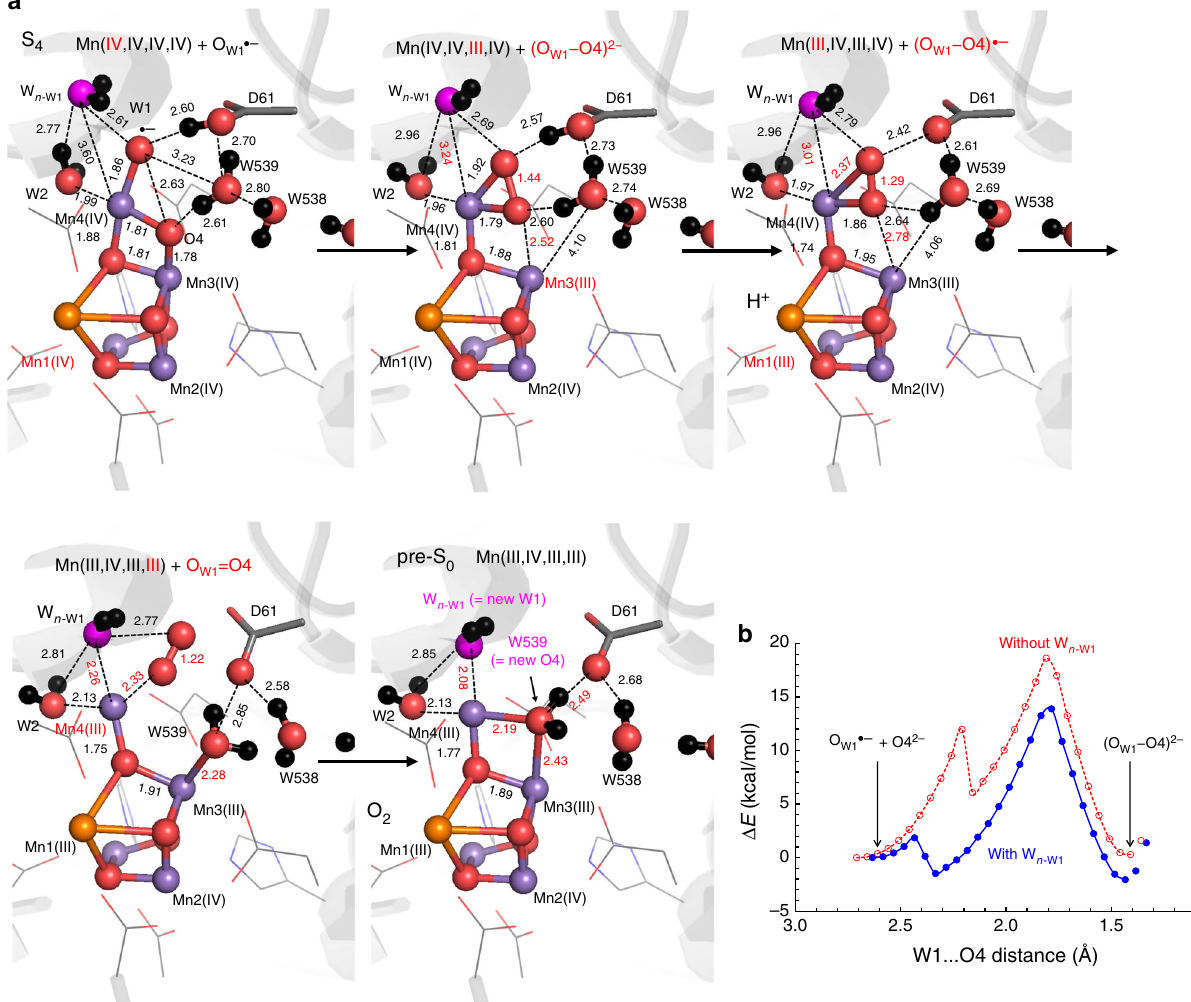
Fig. 4 The S 4 and pre-S 0 states. a QM/MM geometries. Mn, Ca, O, and H atoms are represented by purple, orange, red, and black balls, respectively. Dotted lines indicate distances (excluding H atoms). Release of (O W1 – O4) (cid:129)– from the Mn3/Mn4 moiety (i.e., the Mn3 … O4 distance was increased) resulted in formation of O W1 = O4. See supplementary Figure 4 for the energy pro fi le. b The energy pro fi les of the (O W1 – O4) 2 − formation (the fi rst and second panels in a ) in the presence (blue curve) and absence (red curve) of W n -W1 . The initial lower barriers correspond to reorientation of the carboxylate group of D1-Asp61 with respect to O W1 (cid:129)– /(O W1 – O4) 2